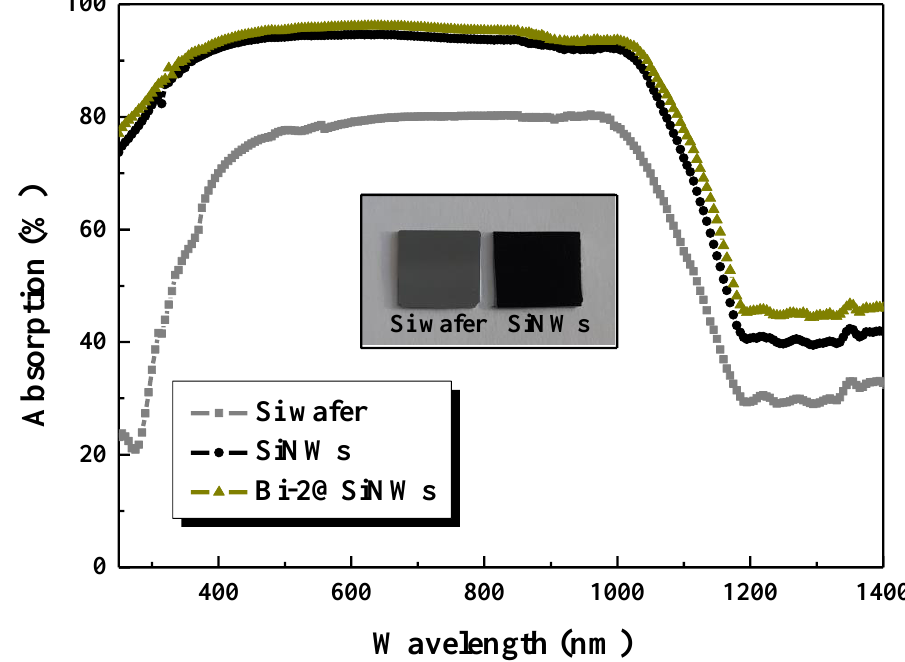
Figure 7. Absorption spectra of silicon wafers, sole SiNW and Bi-2@SiNW compounds .